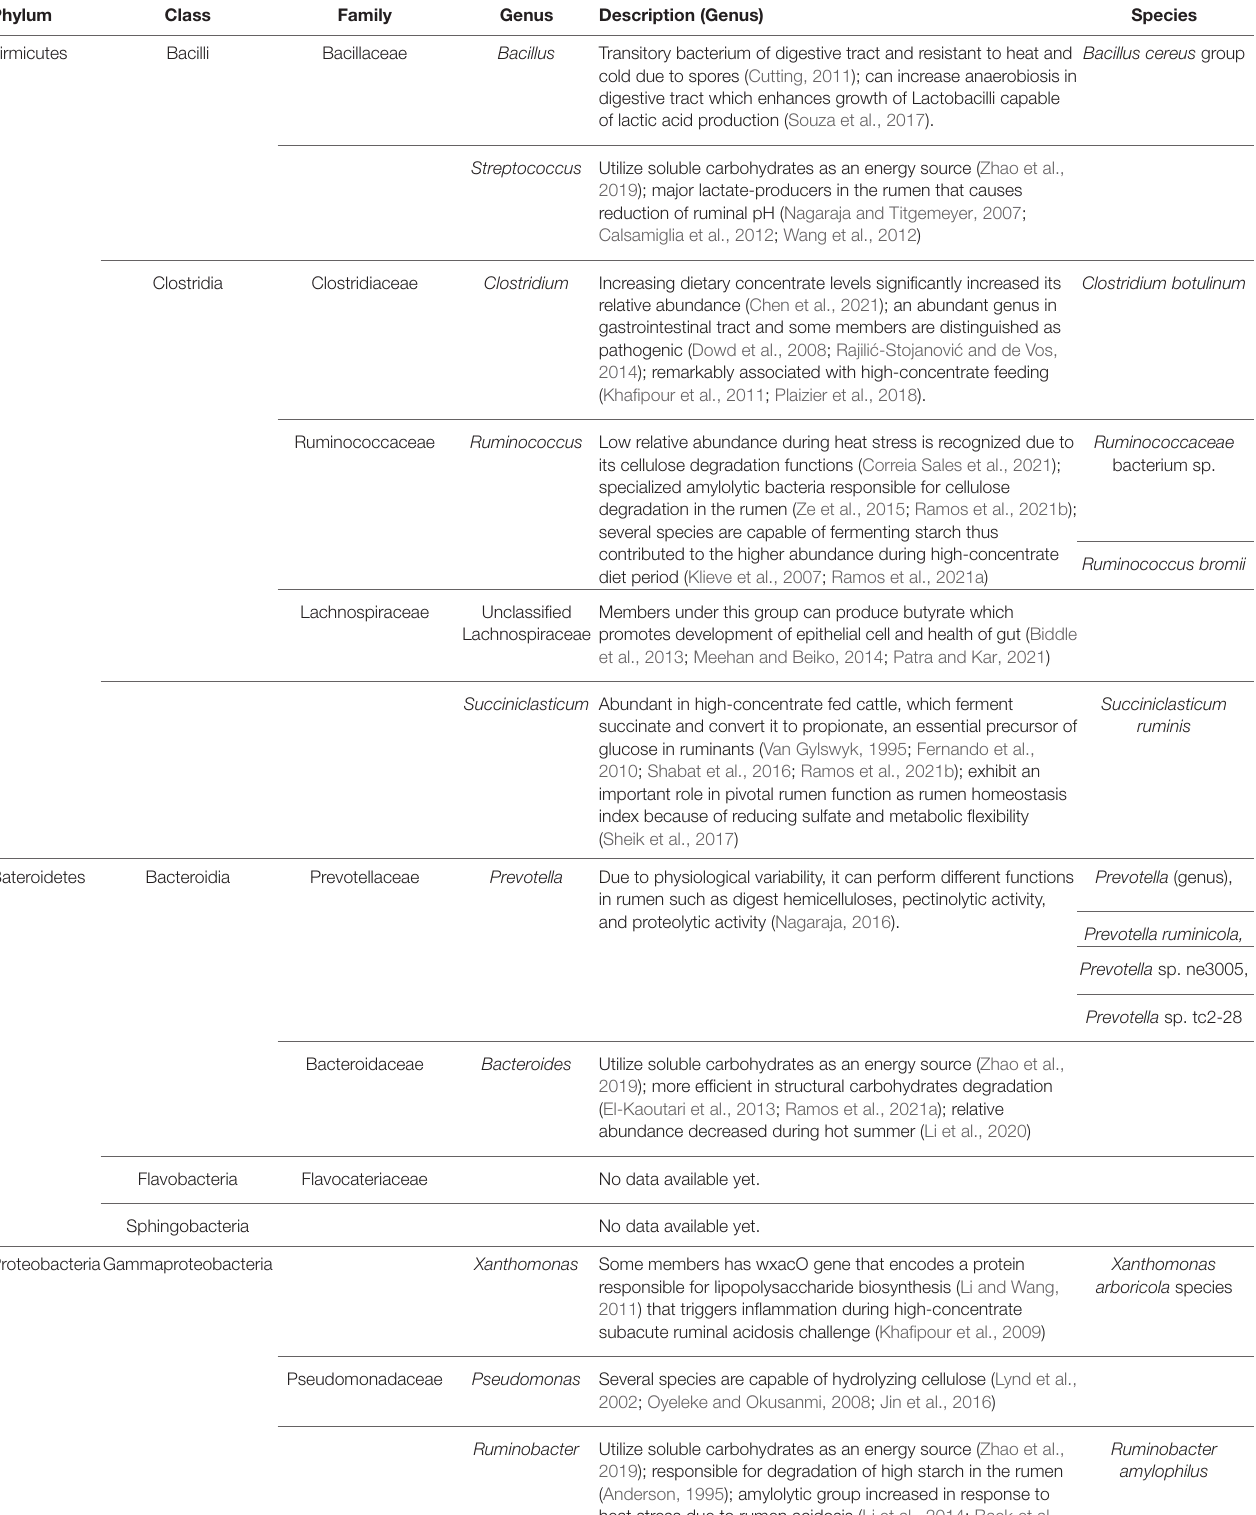
TABLE 1 | Affected phyla, class, orders, family, genera, and species during heat stress, obtained through metataxonomic 16S rRNA gene